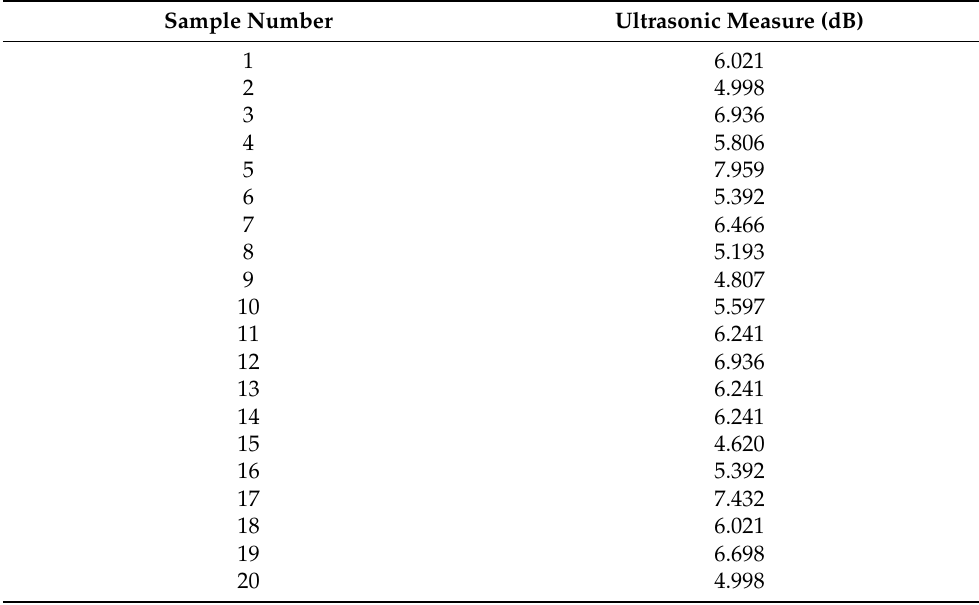
Table A4. Average results of ultrasonic measure for all samples.